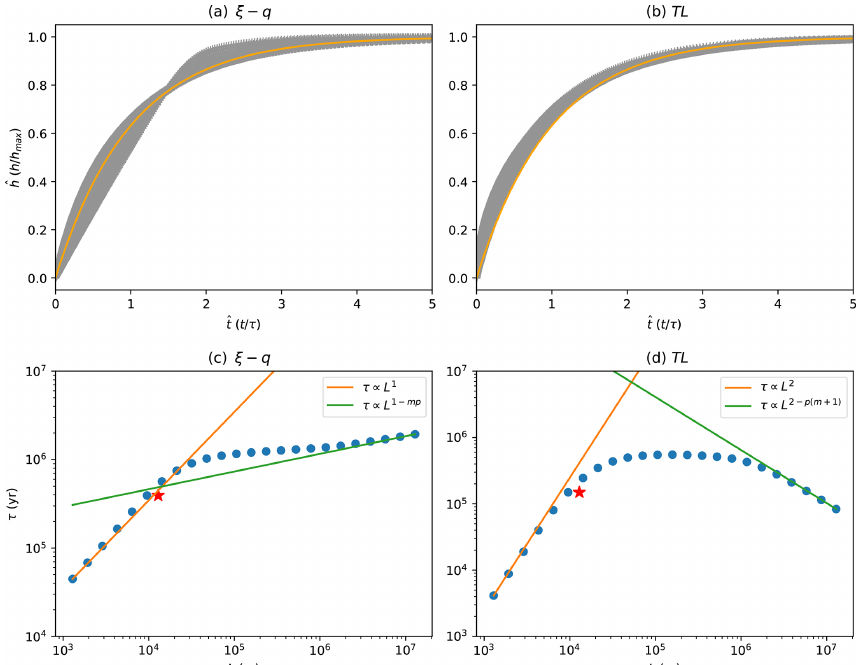
Figure 10. Computed response times for 24 numerical experiments in which the length of the model, L , was varied. (a, b) Time evolution of the maximum height of the depositional system for all 24 experiments (grey curves) normalized to fit an exponential curve (orange curve). (c, d) Corresponding response time estimates (blue circles) on which lines describing the asymptotic behaviors discussed in the text have been superimposed. Note that the absolute values of the response times should be considered with caution as they correspond to a specific choice of relatively poorly constrained values of the rate parameters, K f and K d